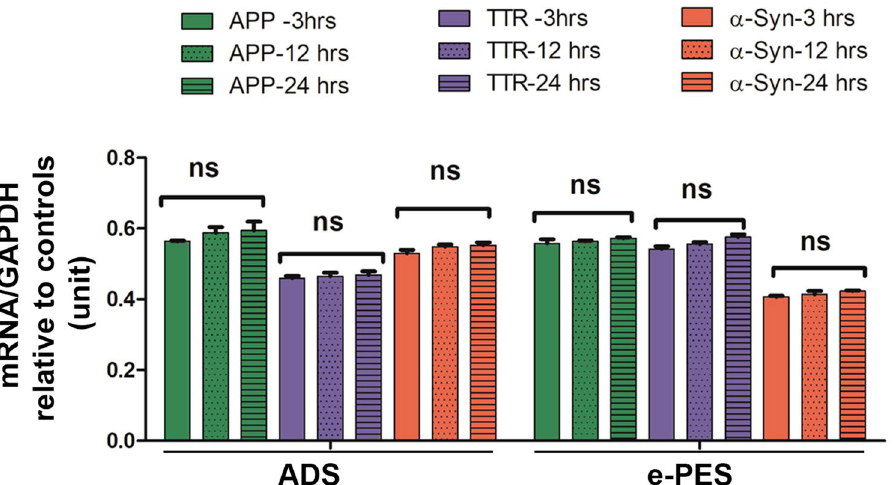
Figure 7. Time-course study of mRNA levels of indicated proteins in ADTs exposed to sera from AD or e-PE patients. ADT were incubated with ADS or e-PES, and total RNA was isolated at indicated time points and then RT-PCR was performed. The mRNA levels were normalized to house-keeping gene, GAPDH. The ratio of the mRNA levels in ADS- or e-PES-treated cells to those in respective control serum-treated cells was calculated to reflect the transcriptional alteration of each protein at each time point and then statistically compared among the groups. Data are expressed as mean ± SEM and analyzed by one-way ANOVA (n = 12). ns not statistically